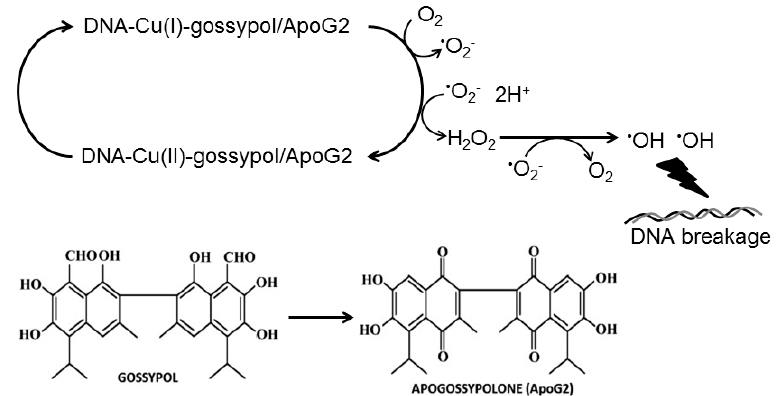
Figure 6. The redox cycling of the ternary complex involving gossypol/ApoG2, copper ions and DNA leading to the generation of various ROS species has been demonstrated in the schematic model along with the chemical structures of gossypol and ApoG2.